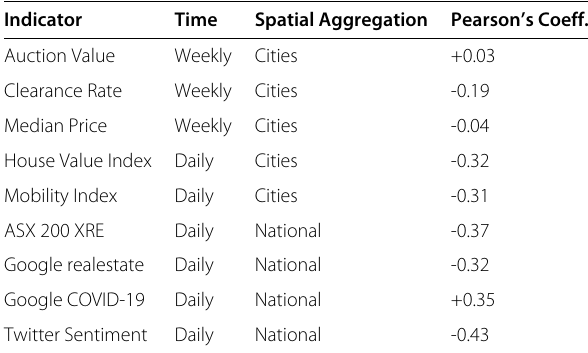
Table 3 Correlation Coefficients of the Various Indicators to the Corresponding COVID-19 Cases Indicator Spatial Aggregation Pearson’s